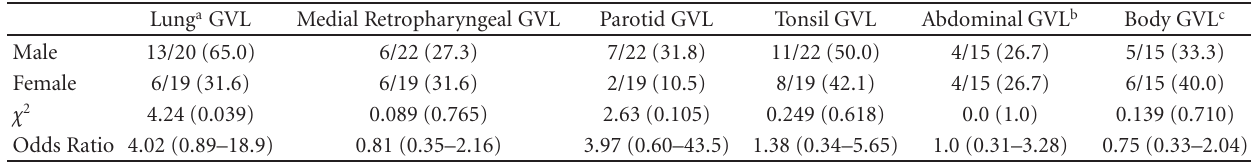
Table 4: Proportion of culture positive elk with gross visible lesions (GVL) in di ff erent tissues and body sections stratified by sex.